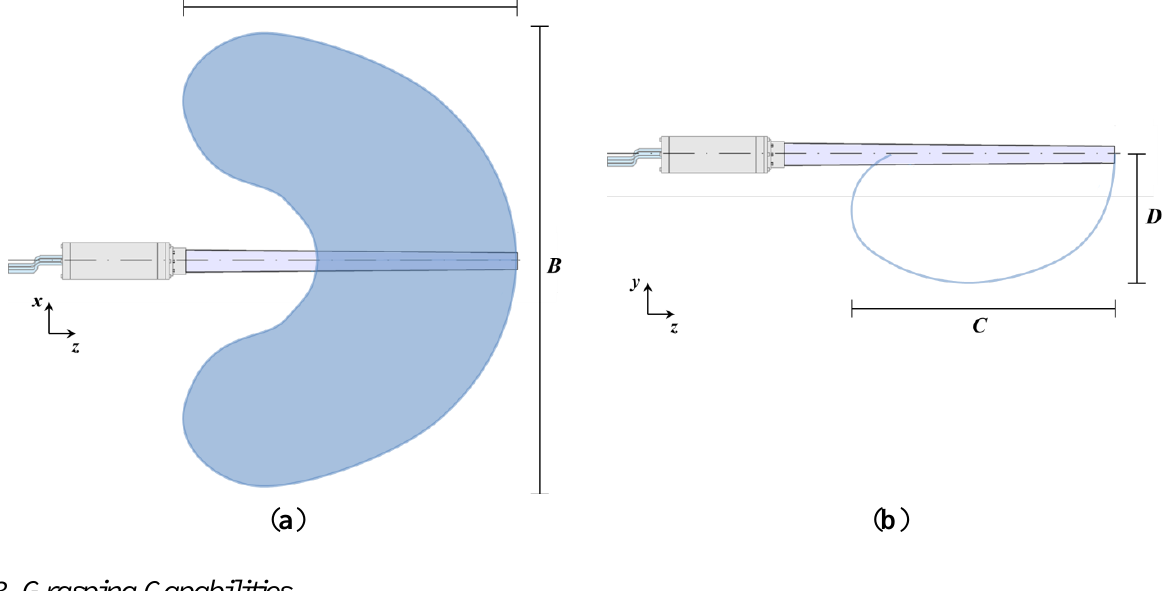
Figure 9. Graphical description of the workspace limits on xz ( a ) and yz ( b )